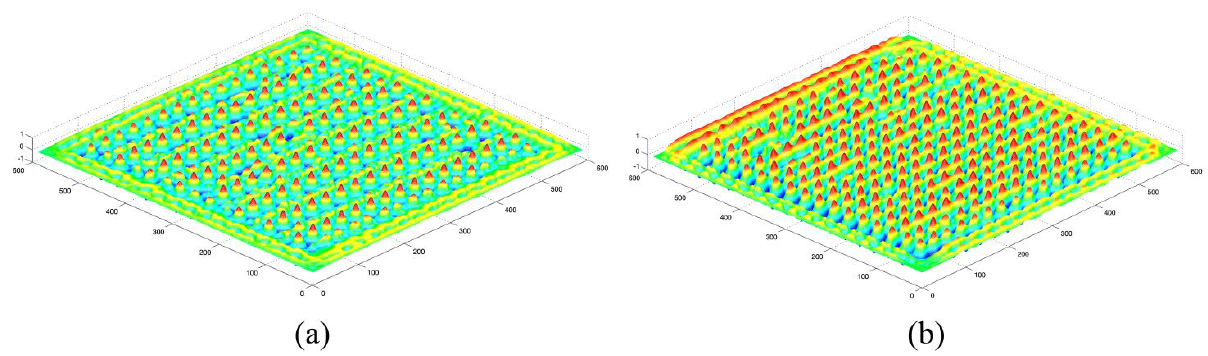
Figure 6. The NCC output matrices of the referenced solder bump image to the SAM images of flip chips I ( a ) and II ( b